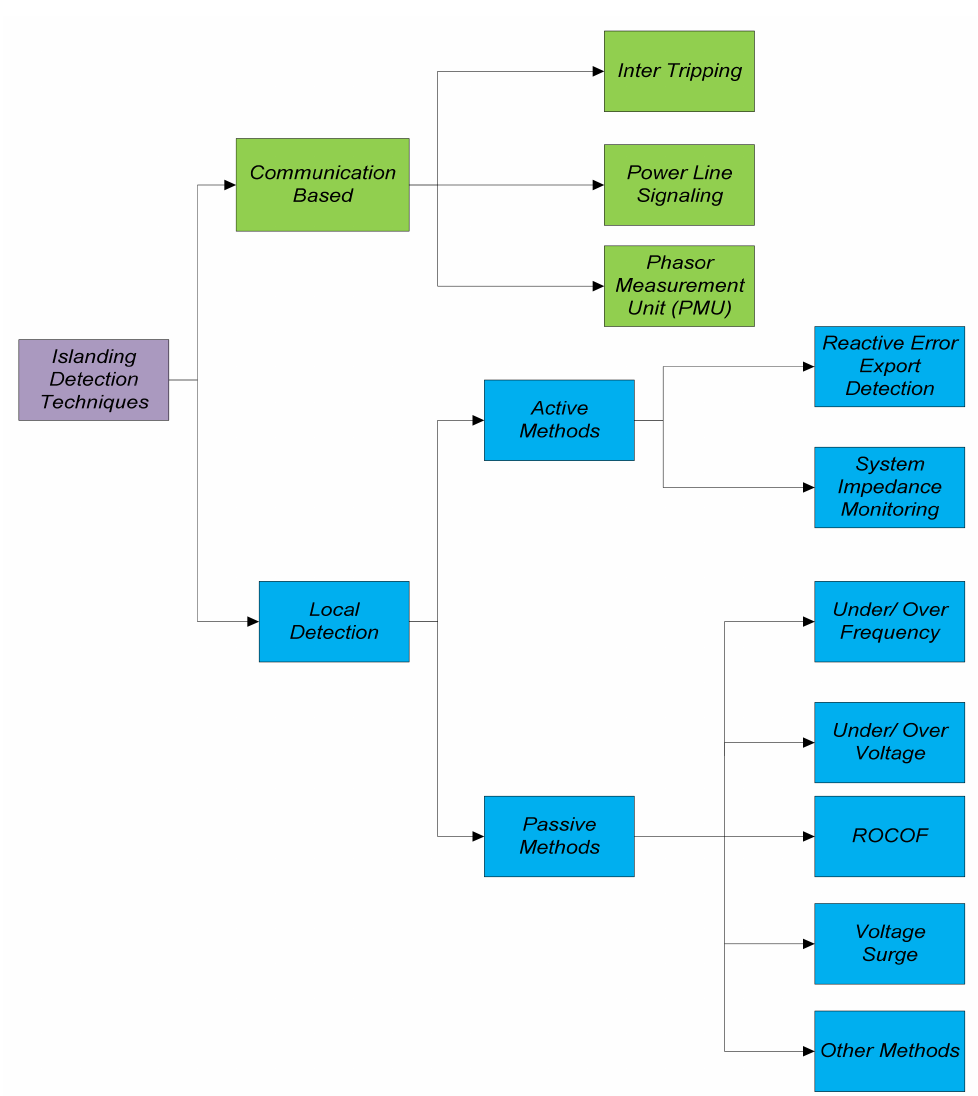
Figure 6. Classification of islanding detection